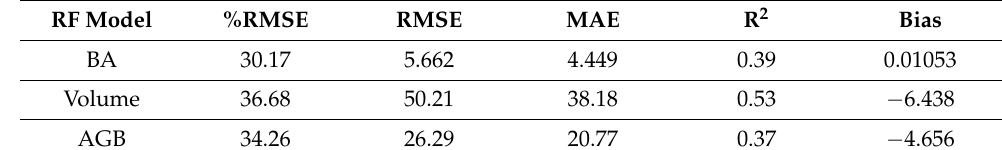
Table 6. Model evaluation of the RF predictions.